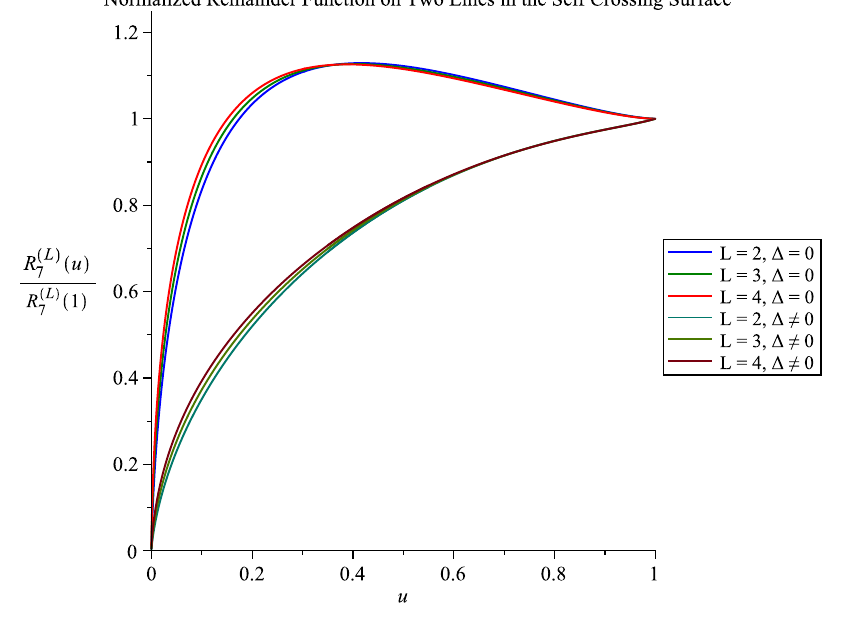
on Line I ((cid:1) 6 = 0) and on Line II ((cid:1) =